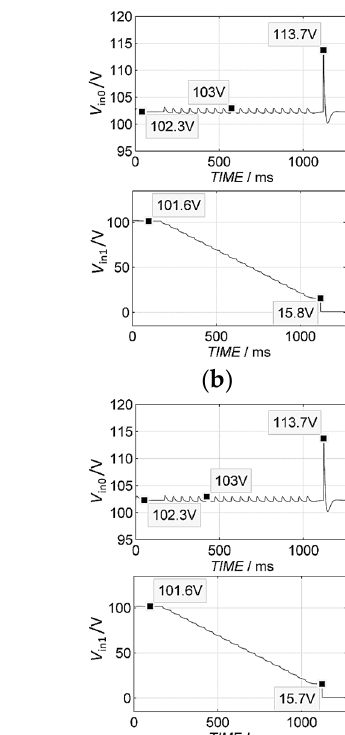
Figure 11. The ( a ) simulated and ( b ) experimental waveforms of the input voltages of module 0 and module 1 with ASB (2 modules).